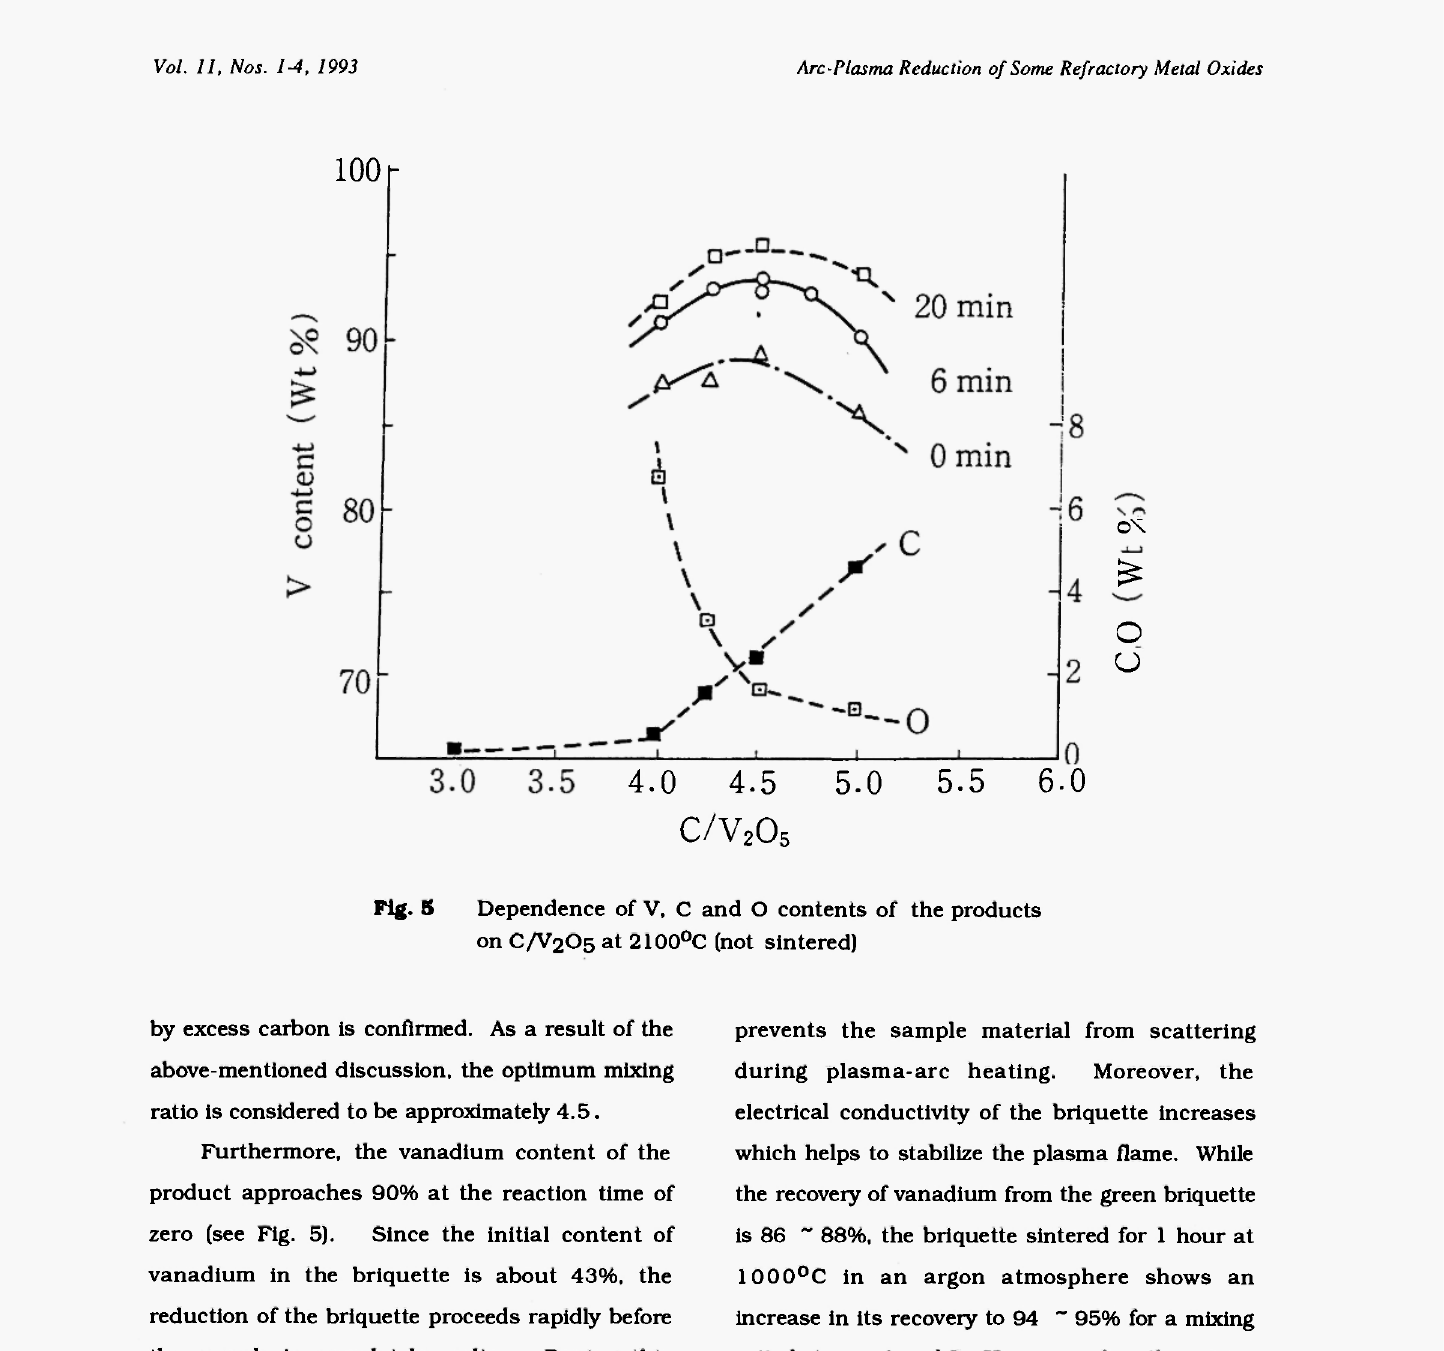
Fig. 5 Dependence of V, C and Ο contents of the products on C/V2O5 at 2100°C (not